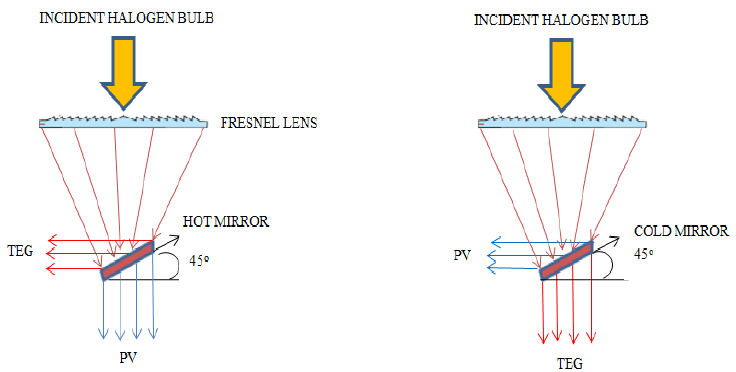
Figure 10. The scheme of PV-TEG hybrid testing with hot and cold mirrors.